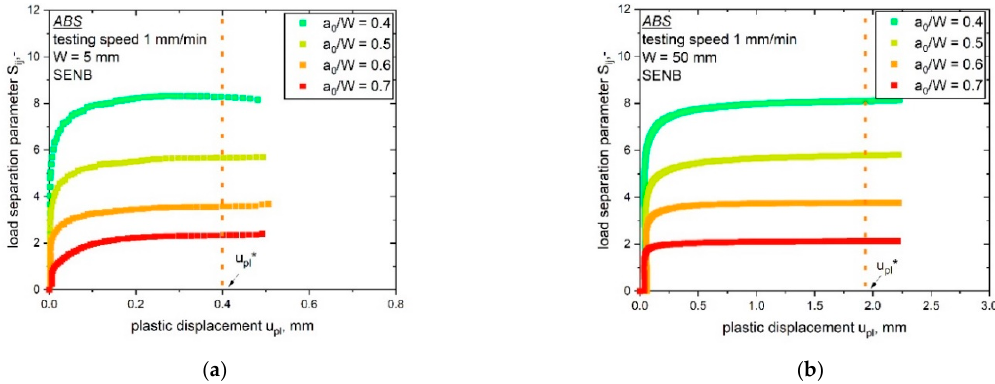
Figure 7. Decreasing load–displacement curves with increasing ratios of notch length over width a 0 /W for two tested bN ABS specimen sizes where W is 5 mm ( a ) and 50 mm ( b ).